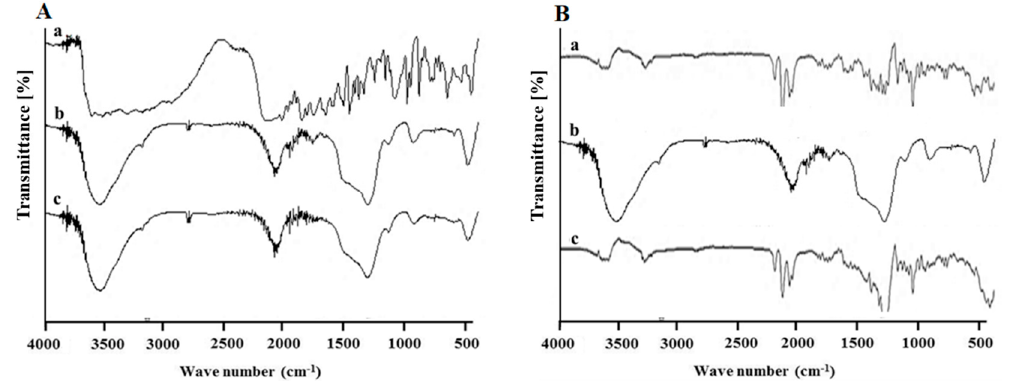
Figure 6. ( A ) FT-IR spectra of (a) 5-FU, (b) MSN-NH 2 , and (c) 5-FU MSN-NH 2. ( B ) FT-IR spectra of (a) DEX, (b) MSN-NH 2 , and (c) DEX MSN-NH 2.